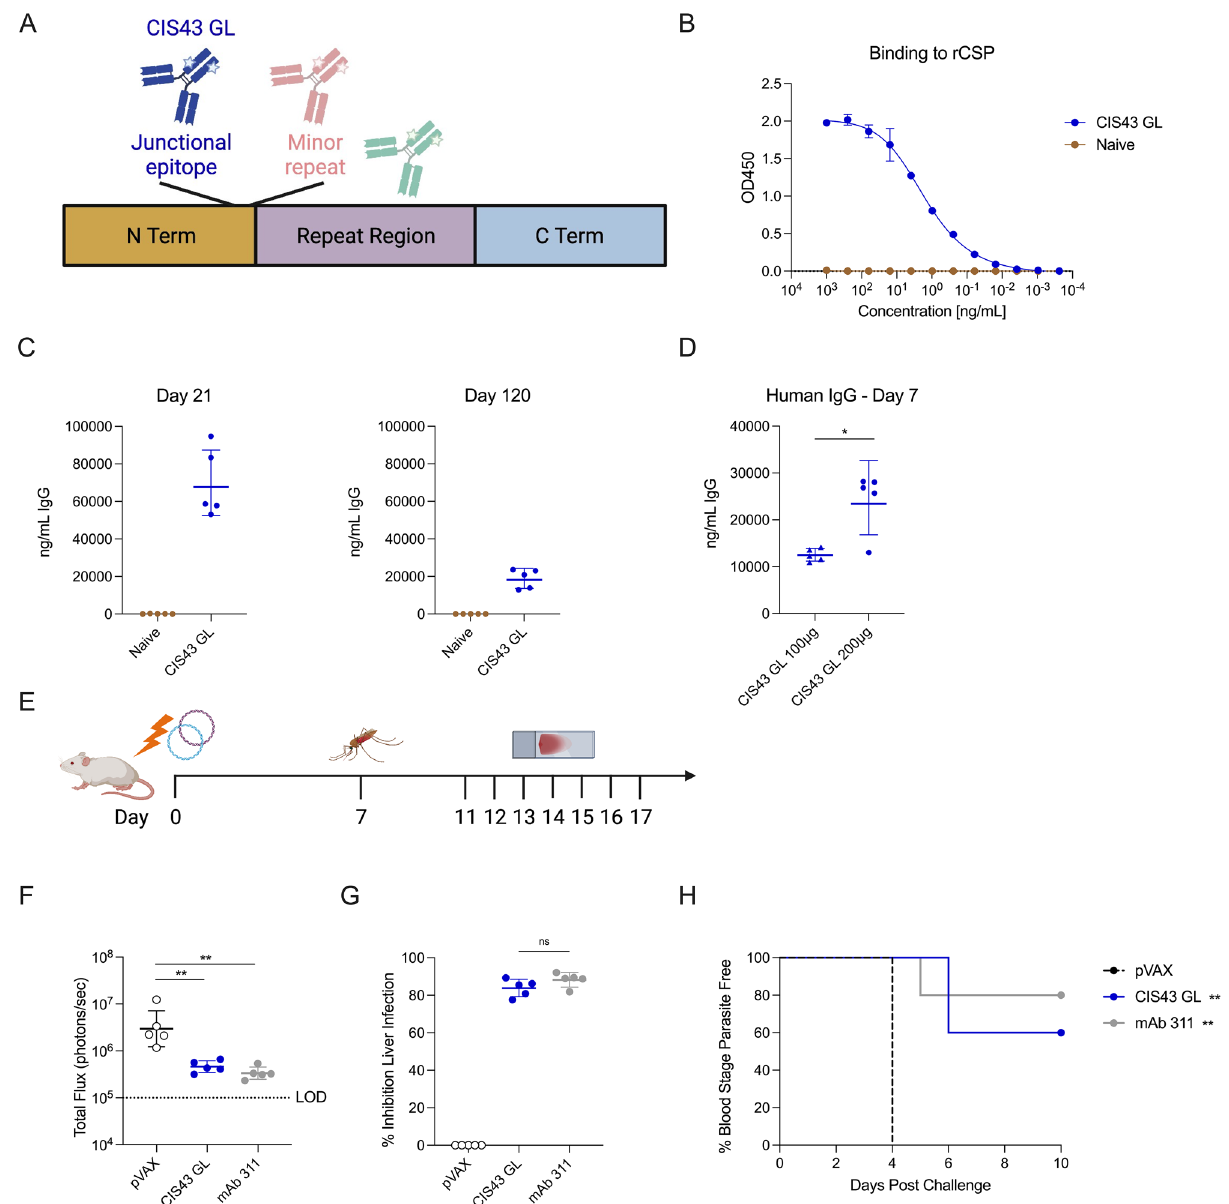
Figure 1. Proof-of-concept CIS43 GL DMAb protects mice in mosquito bite challenge. ( A ) Schematic demonstrating CIS43 GL binding domain on CSP. ( B ) Binding ELISA of pooled supernatants harvested from Expi293F transfection to rCSP (mean ± SD). ( C ) In vivo expression of CIS43 GL in BALB/c mice at the peak expression timepoint Day 21 (left) through Day 120 (right). Mice were immunized with 100 µg CIS43 intramuscularly in the tibialis anterior with CD4+/CD8+ T cell depletion (n = 5 mice/group; geometric mean ± geometric SD). ( D ) In vivo expression of CIS43 GL in BALB/c mice without CD4+/CD8+ T cell depletion (n = 5 mice/group; geometric mean ± geometric SD). Mice were administered 100 µg or 200 µg intramuscularly in the tibialis anterior and/or quadricep. *p = 0.032 by two-tailed Mann–Whitney test. ( E ) Experimental layout of challenge. Mice were immunized with CIS43 GL and challenged 7 days post administration with mosquitos carrying PbPfLuc parasites. Positive control recombinant mAb 311 was administered 16 h prior to challenge. Blood smears for blood stage parasitemia were performed from days 4–10 post challenge. ( F ) Total flux quantified by IVIS; ** p = 0.0079 by two-tailed Mann–Whitney test (geometric mean ± geometric SD) ( G ) Percent inhibition of liver infection relative to infection of pVAX control infected mice (geometric mean ± geometric SD). ( H ) Percent of blood stage parasite free mice, determined through blood smears (n = 5 mice/group). **p < 0.01 versus pVAX by Log-rank (Mantel–Cox) test). The positive and negative controls were historical as we have published in Ref. 47